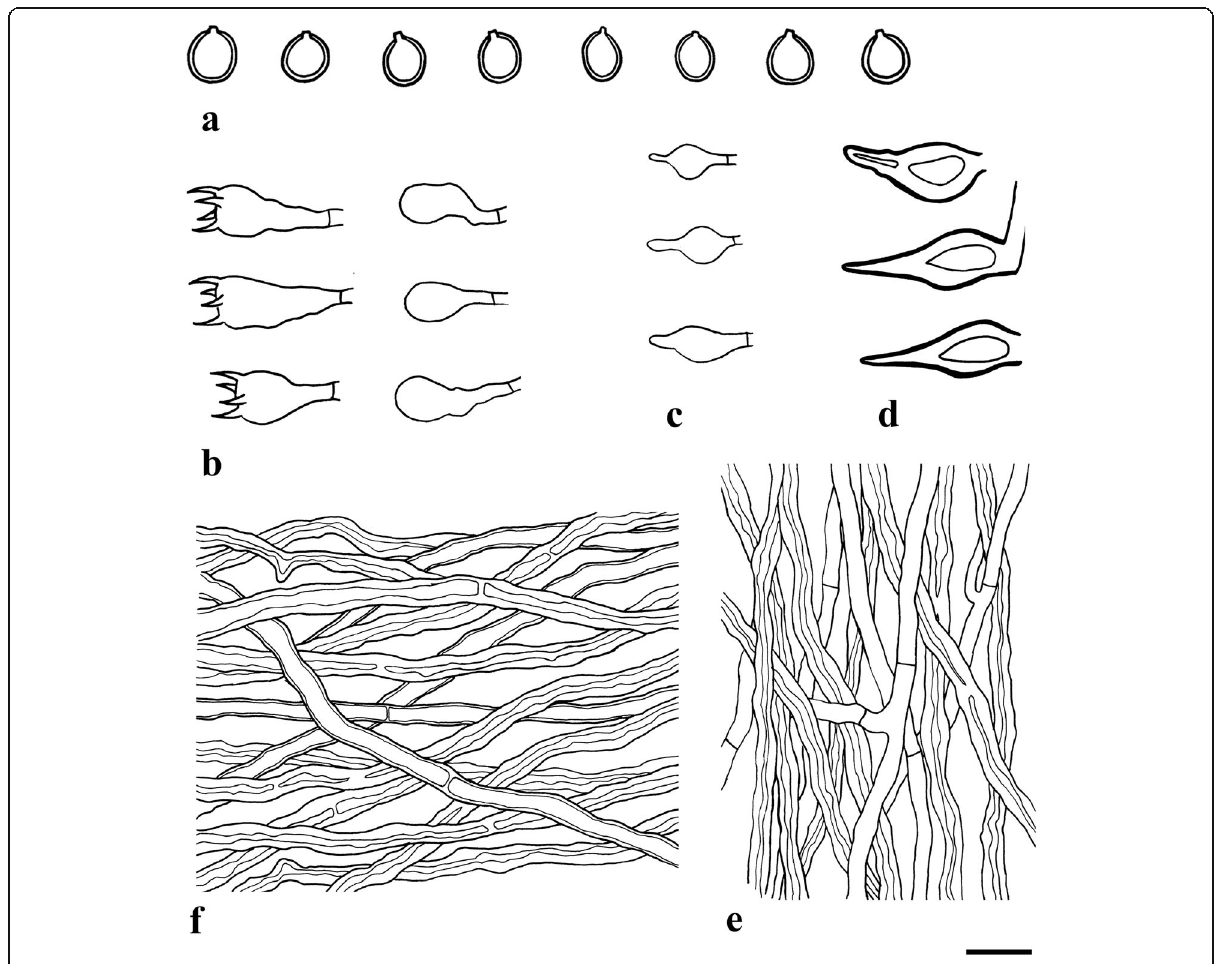
Fig. 4 Microscopic structures of Sanghuangporus subbaumii (drawn from Dai 13360, holotype). a Basidiospores. b basidia and basidioles. c cystidioles. d hymenial setae. e hyphae from trama. f hyphae from context. Bars: a = 5 μ m, b – e = 10 μ